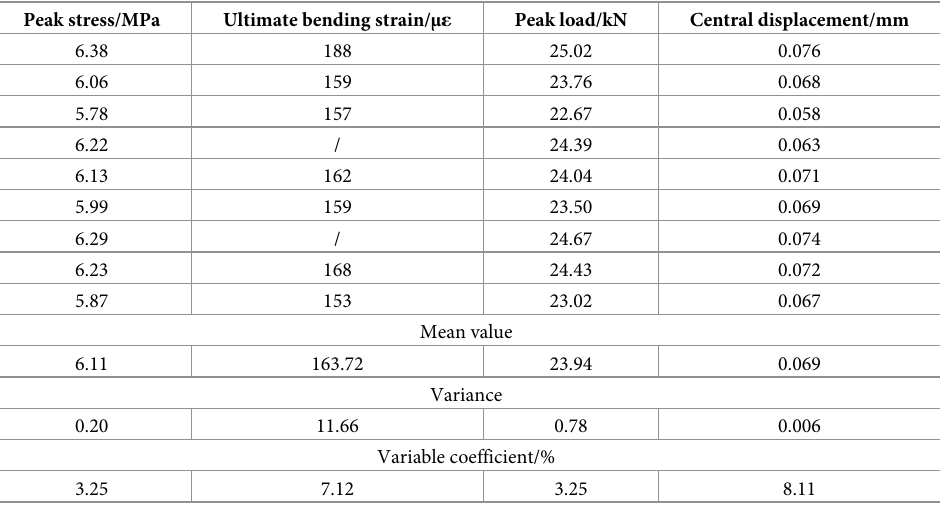
Table 6. Bending resistance of concrete